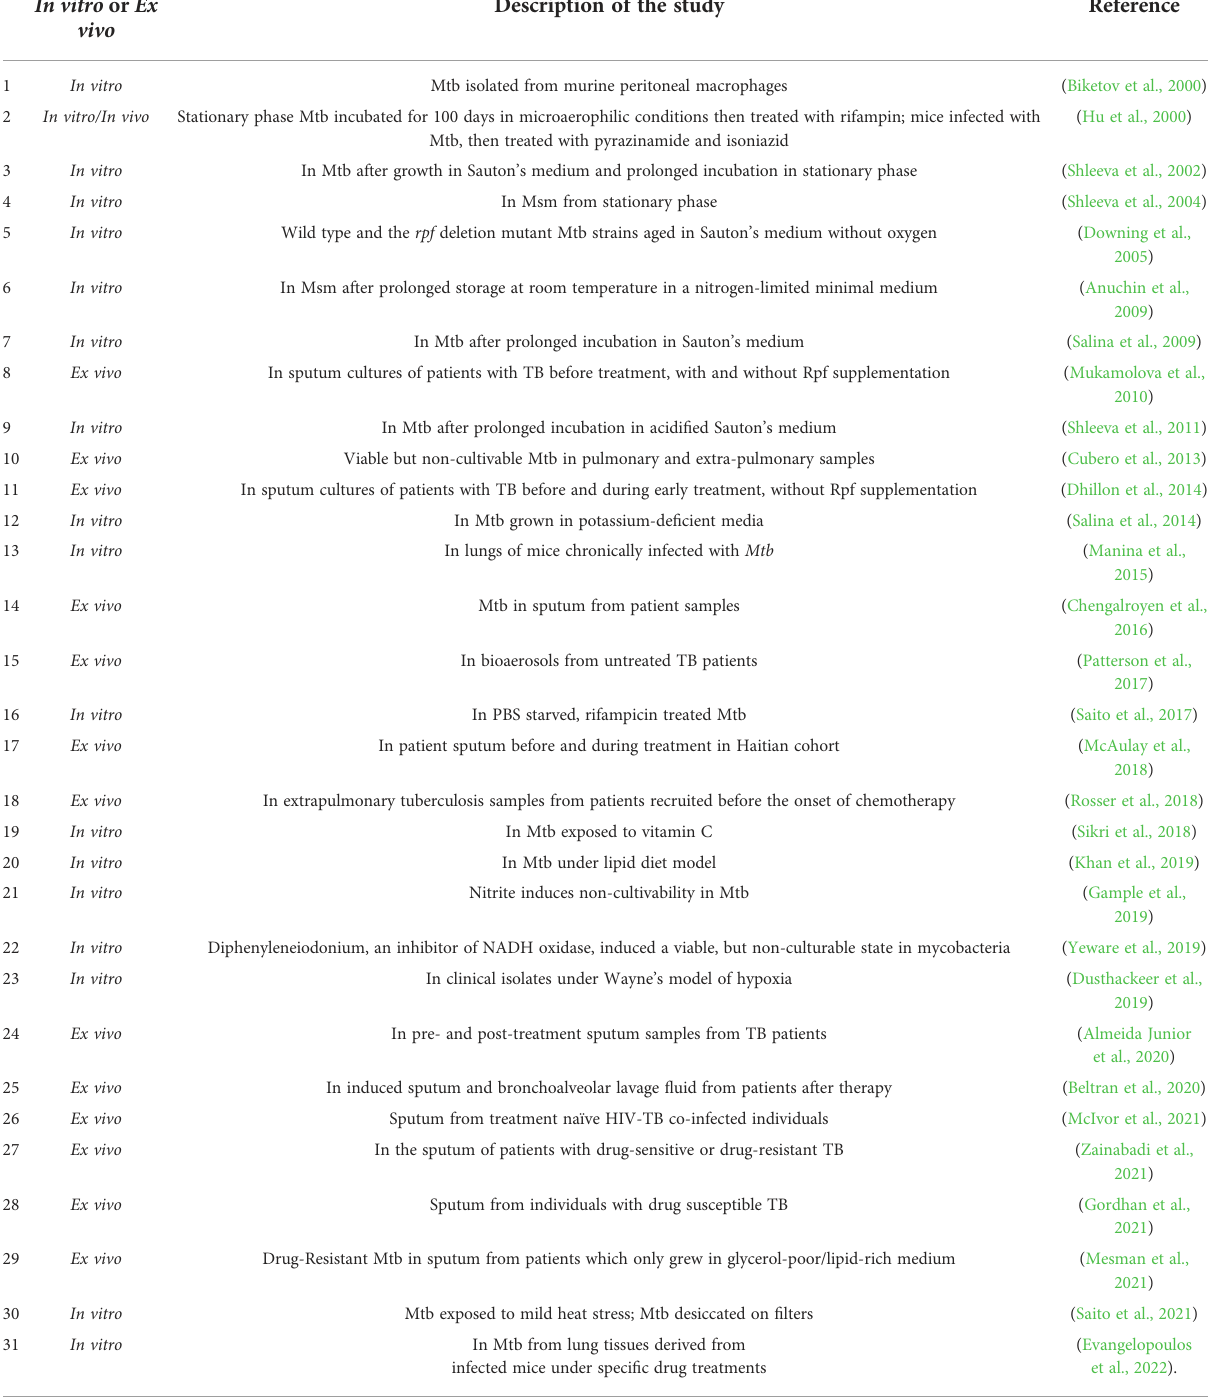
TABLE 1 In vitro and ex vivo studies of differentially detectable Mtb and DD Msm. In vitro or Ex